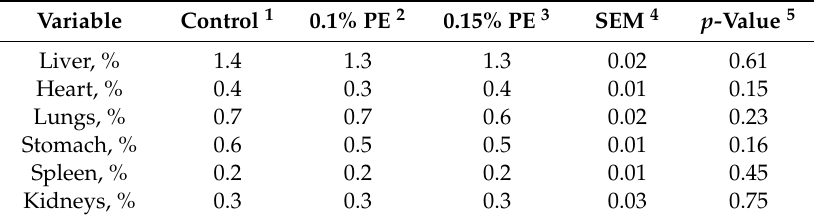
Table 5. Organ weight as a percentage of live weight (%).